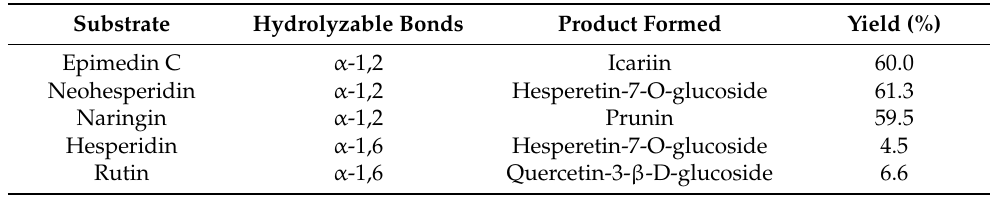
Table 2. Substrate specificity of α